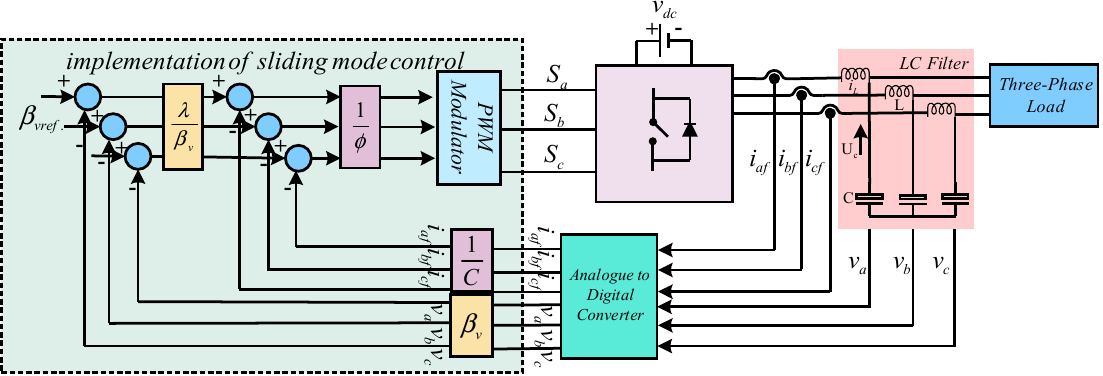
Figure 26. A Sliding mode control technique on a VSI.